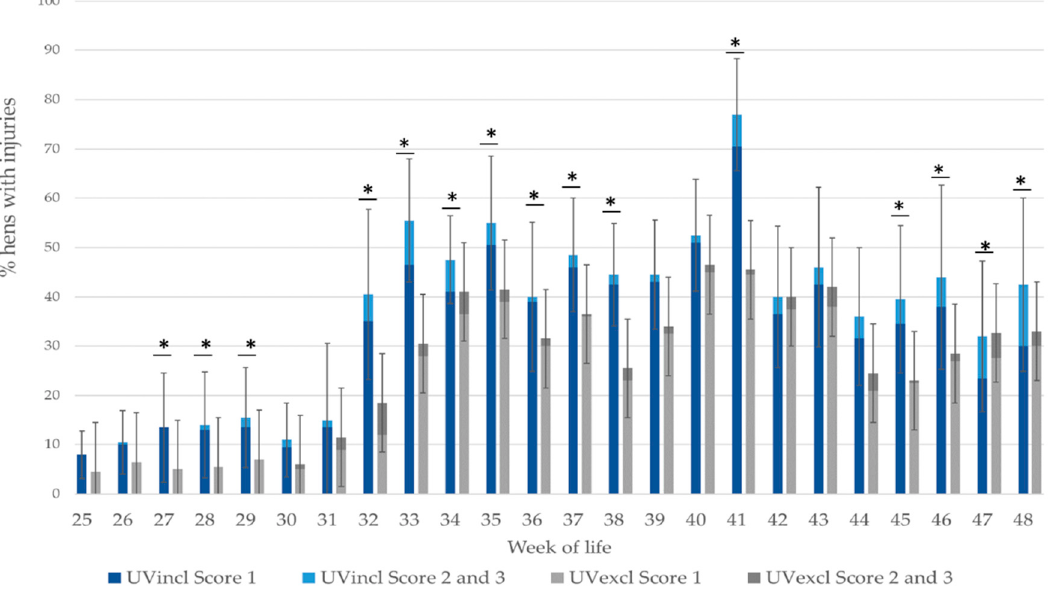
Figure 6. Percentage of hens with skin injuries on at least one body region ( n = 200 hens / lighting group and week) during production period depending on light spectrum (UV-A light +/ − ). The UVincl group (blue bars) contained significantly more hens with severe injuries compared to the experimental group with standard lighting (UVexcl group; grey bars). * Significant differences in the percentage of hens with skin injuries (score 1 or higher) on at least one body region ( p < 0.05; WL: 27, 28, 29, 32, 33, 34, 35, 36, 37, 38, 41, 45, 46, 47, 48).